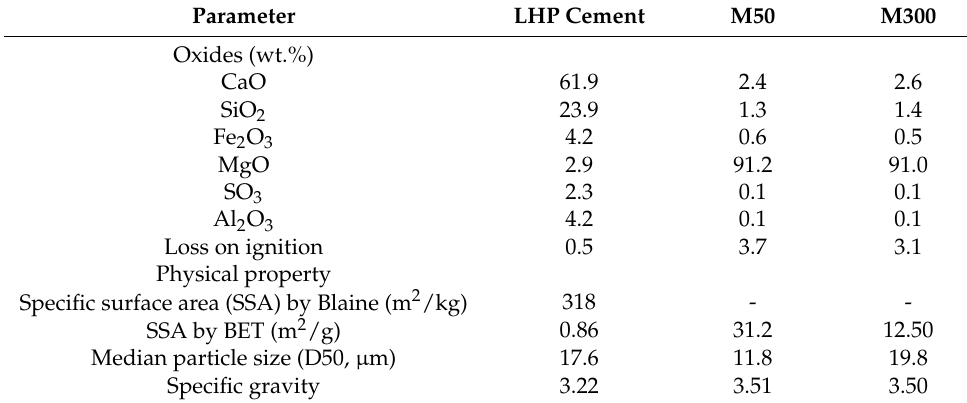
Table 1. Physical property, chemical oxides of LHP cement, and MgO.